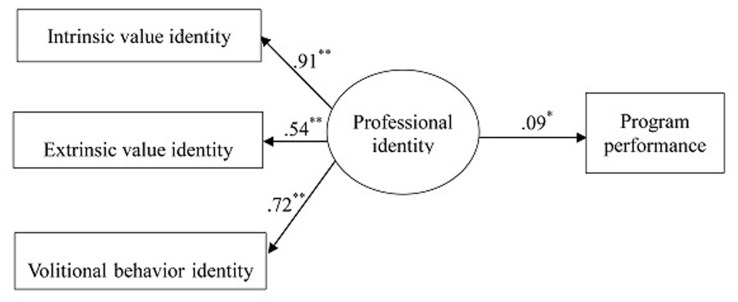
Basic Model (Model 1). Model fit: χ2(2) = 2.07, p = 0.35, CFI = 1.00, RMSEA = 0.008, 90% CI = 0.00 -0.08, SRMR = 0.01. ∗p ≤ 0.05, ∗∗p ≤ 0.01.